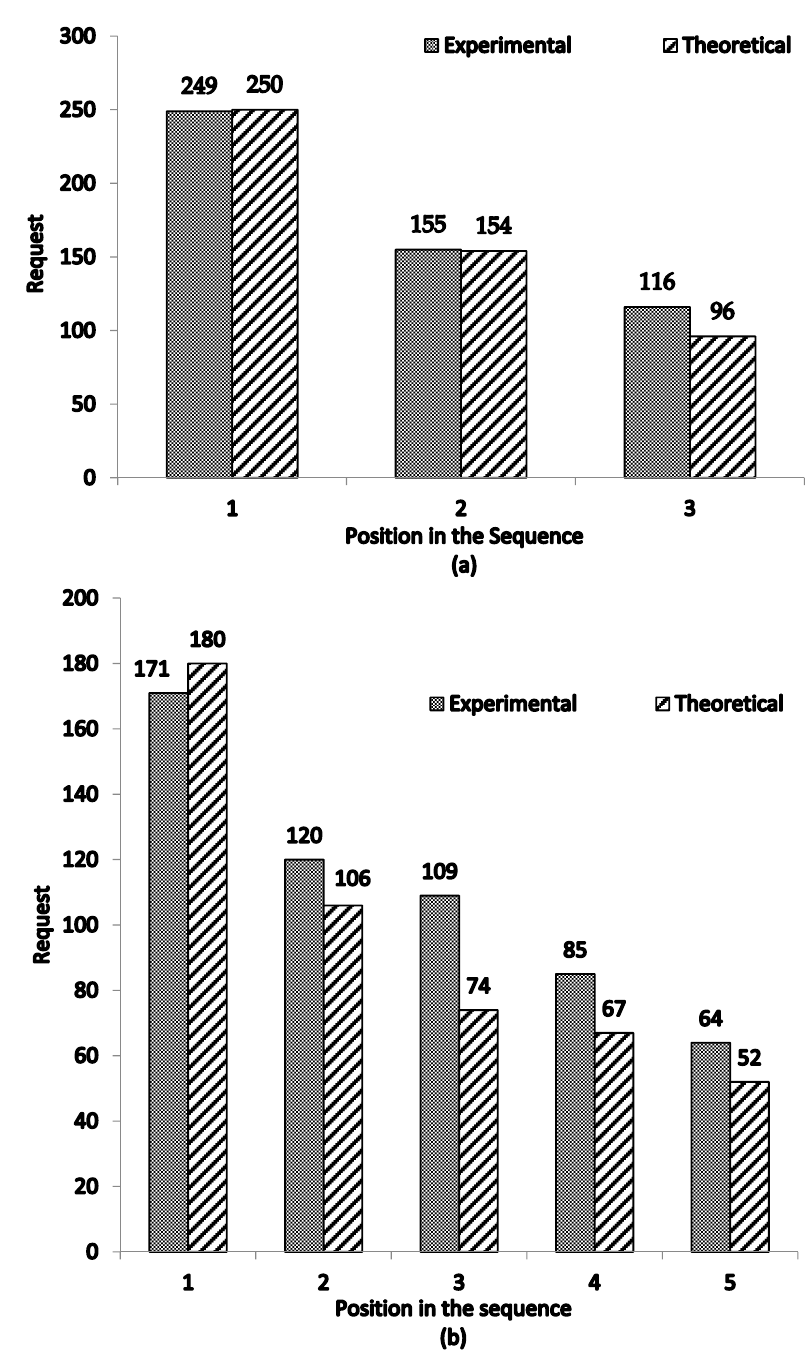
Figure 3. Empirical and predicted mean of requests in a sequential common pool resource (CPR) Dilemma with resource size = 500 for three players ( a ); and five players ( b ). Dilemma with resource size = 500 for three players ( a ); and five players ( b